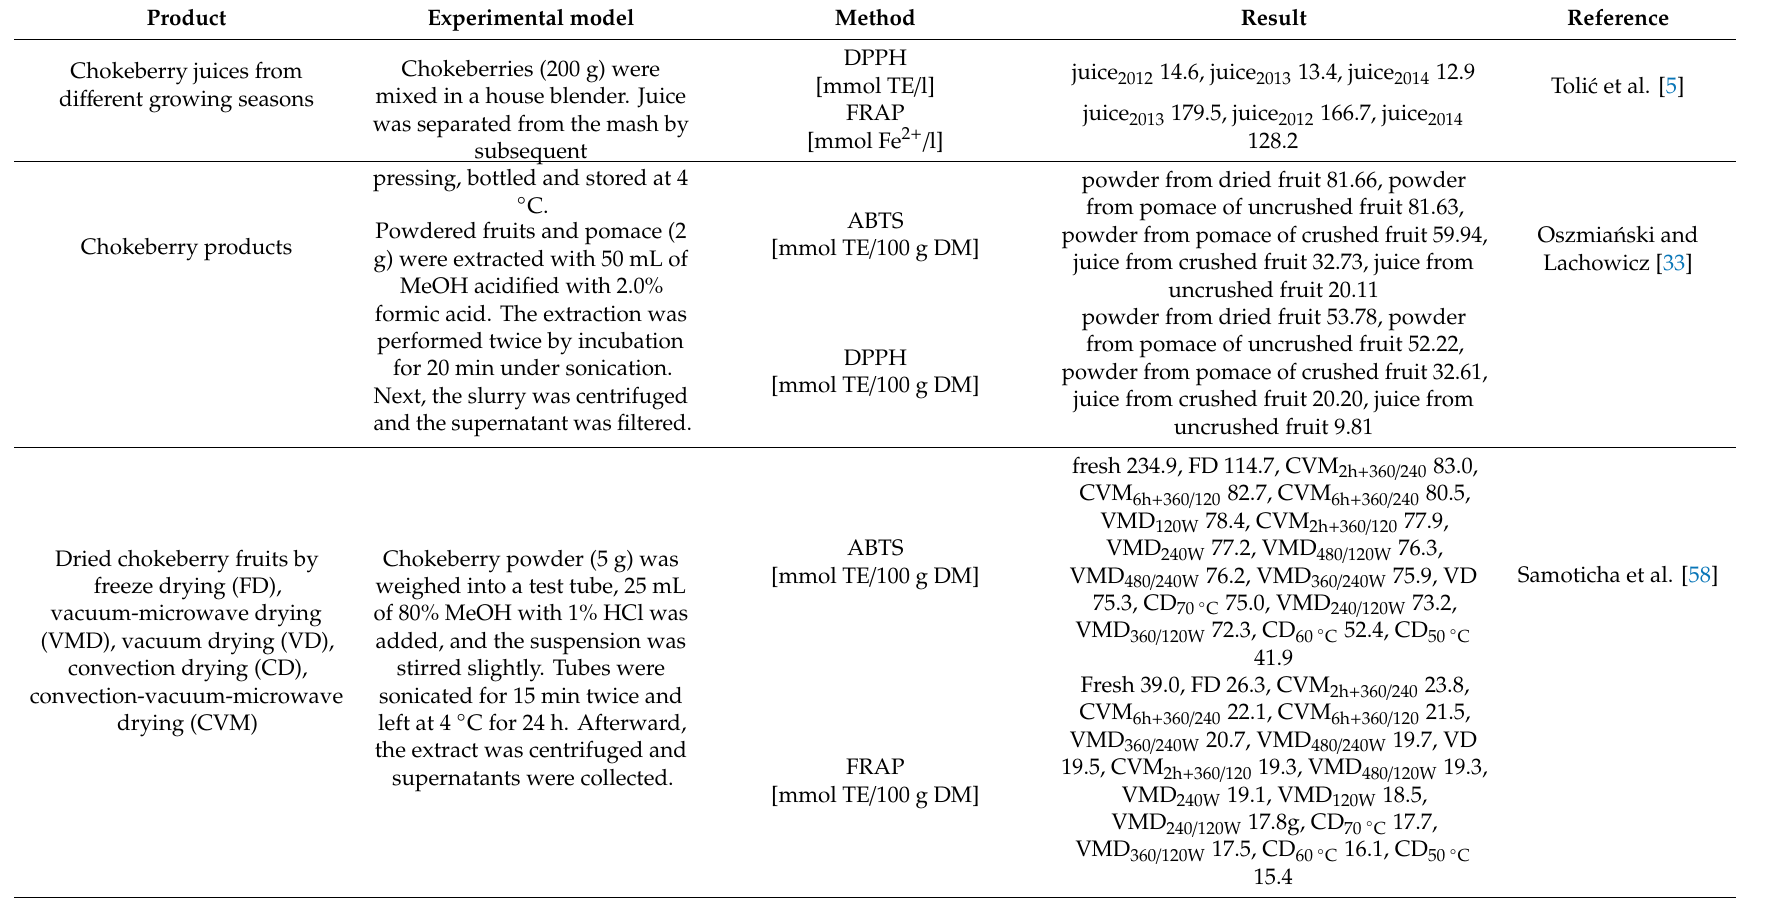
Table 3. Antioxidant activity of chokeberry fruits and